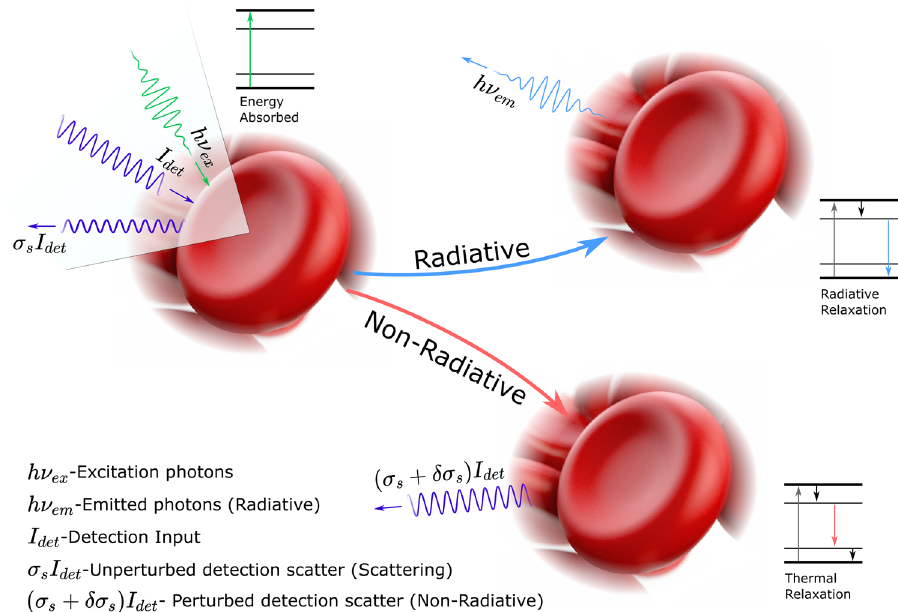
Figure 1. TA-PARS contrast mechanisms. Each excitation always generates some fraction of radiative and non-radiative relaxation effects. The non-radiative relaxation leads to heat and pressure induced modulations, which in turn cause back-reflected intensity variations in the detection beam. PARS signals are denoted as some change in reflectivity multiplied by the incident detection (( σ s + δσ s ) I det ) . The radiative absorption pathway captures optical emissions attributed to radiative relaxation such as stimulated Raman scattering, fluorescence, multiphoton fluorescence, etc. Emissions are denoted as some wavelength and energy optical emission ( h ν em )